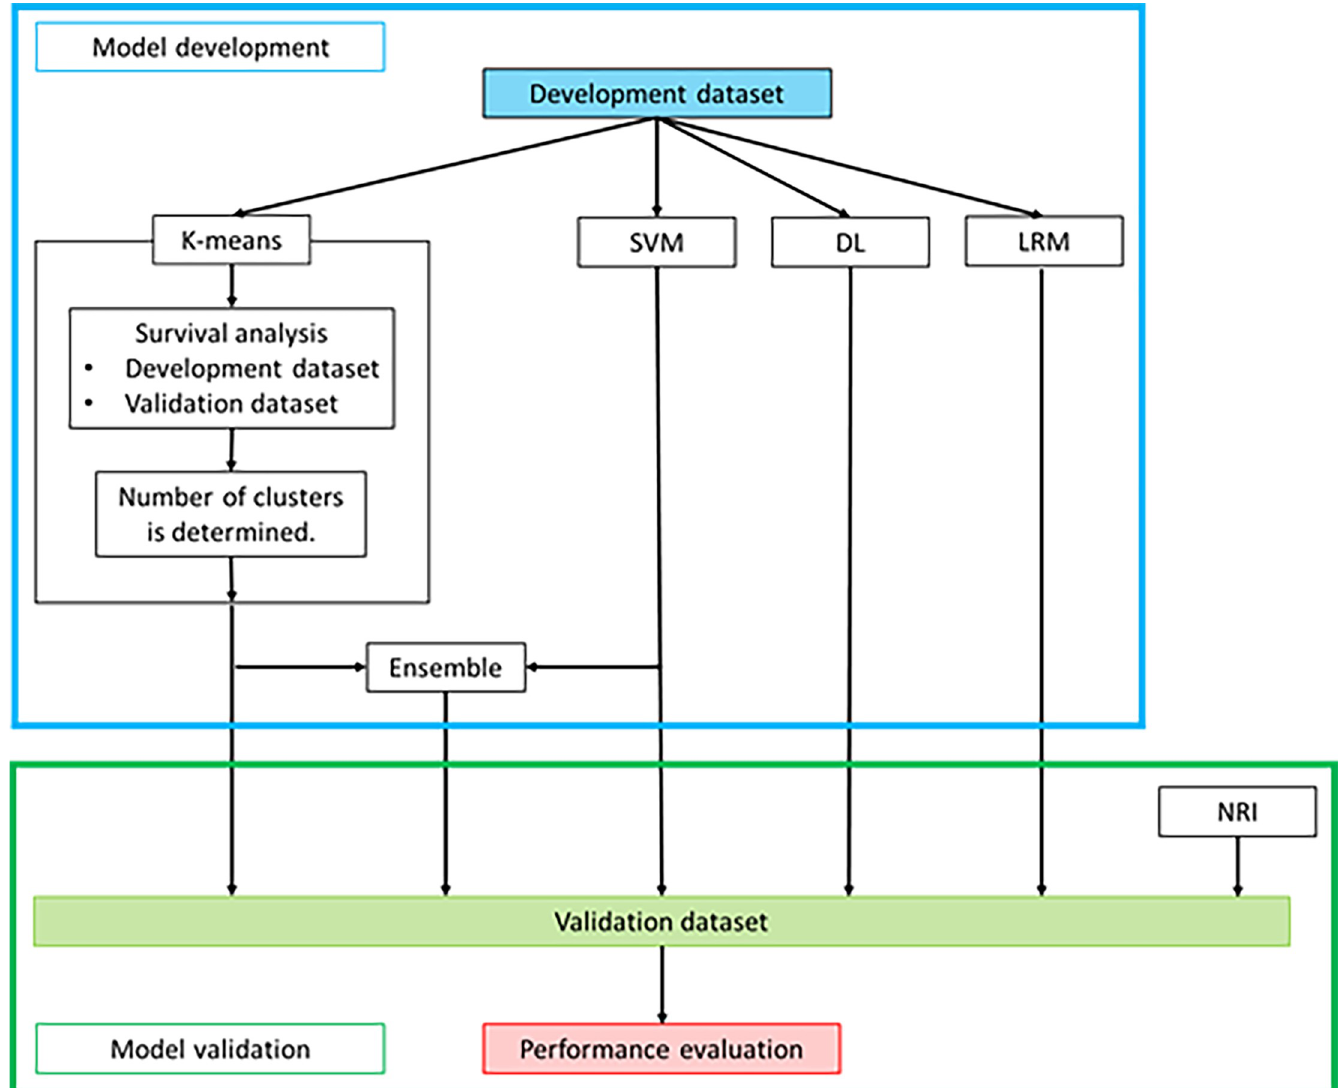
Fig 5. Development of machine learning models and comparison of their performance. This study consisted of the model development phase and model validation phase. In the model development phase, the K-means method model, SVM model, ensemble model, DL model, and LRM were developed. In the model validation phase, the performances of the models and NRI were compared. Abbreviations: SVM, support vector machine; DL, deep learning; LRM, logistic regression model; NRI, nutritional risk index.